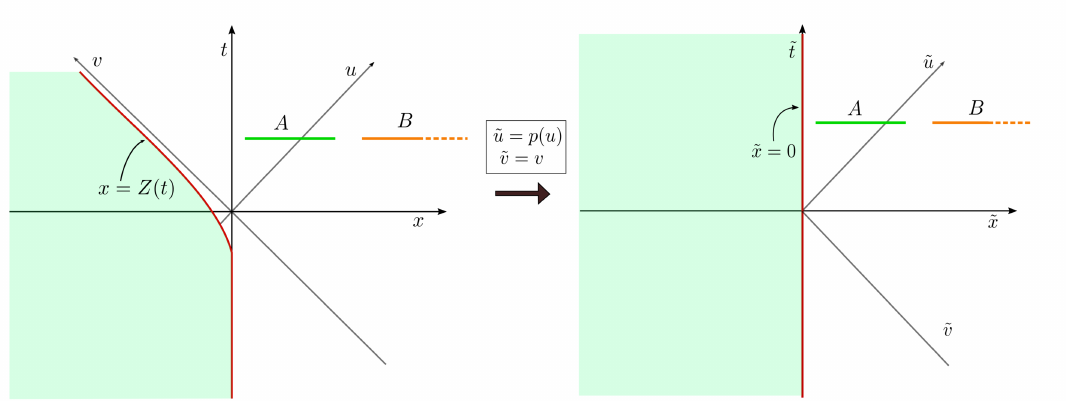
Figure 2. Conformal transformation to the static mirror setup. Schematics of two disjoint inter- vals A = [(˜ t 1 , ˜ x 1 ) , (˜ t 2 , ˜ x 2 )] and B = [(˜ t 3 , ˜ x 3 ) , (˜ t 4 , ∞ )] in the static mirror BCFT. Figure modified from